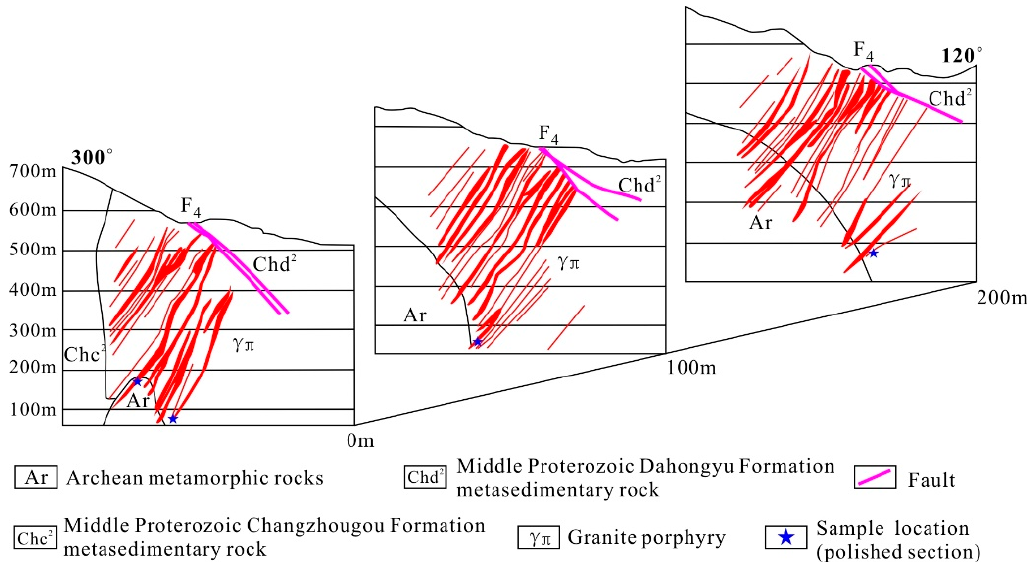
Figure 3. Joint section map of the Line 15–Line 11–Line 7 ore bodies (from left to right) of the Xiajinbao gold deposit.